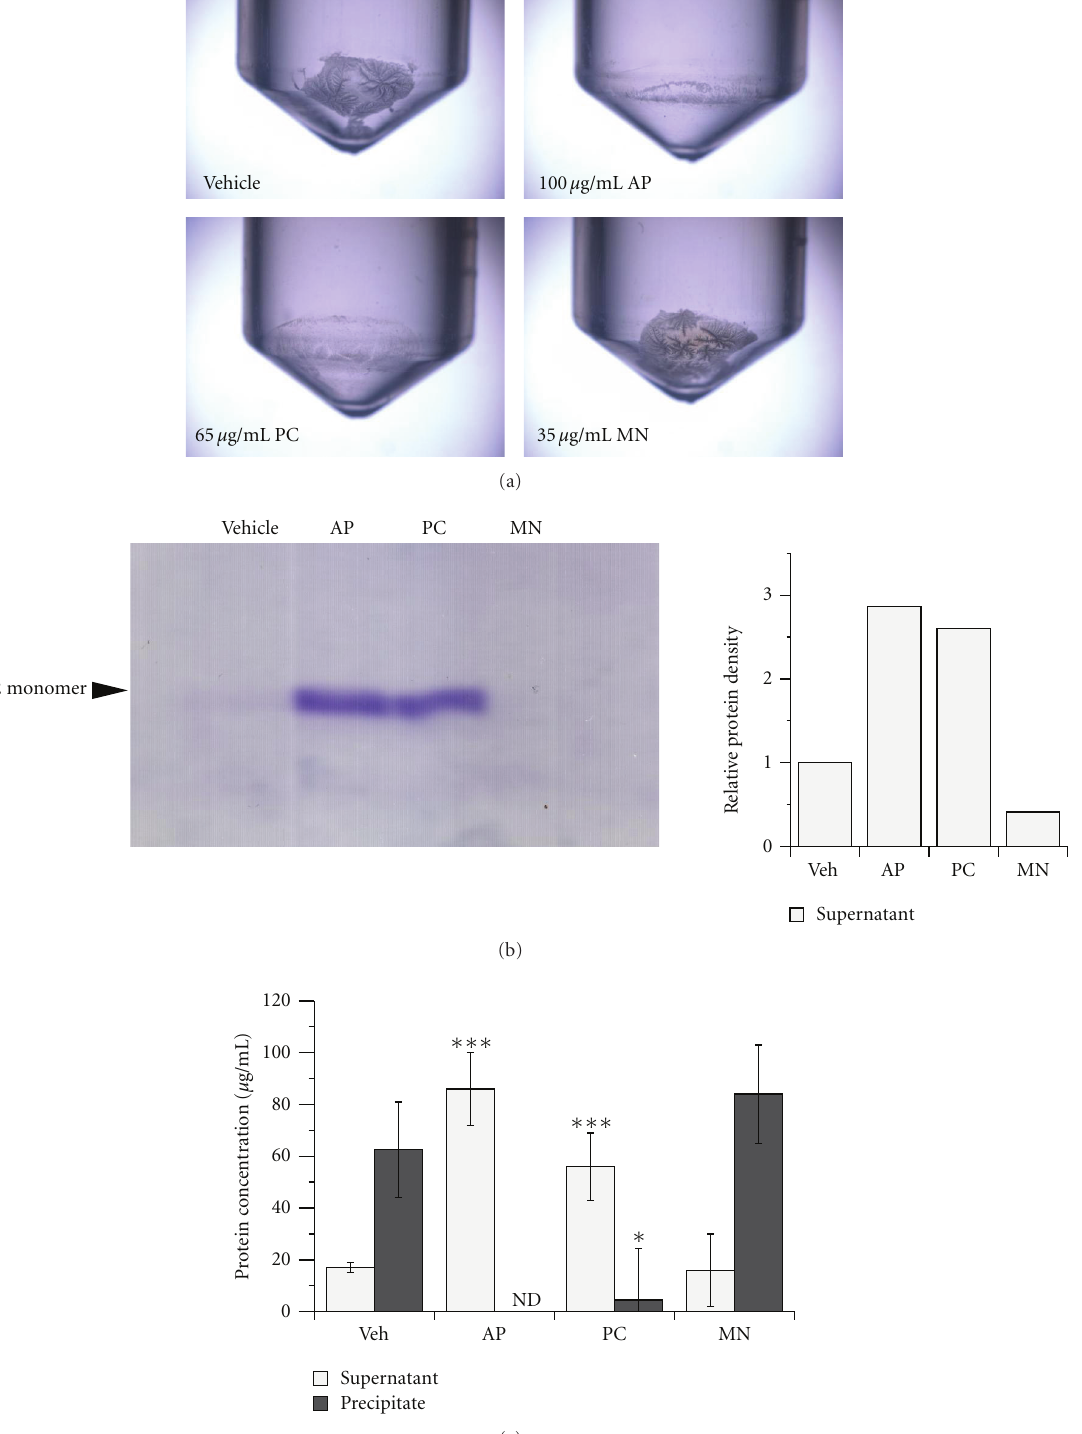
Figure 2: Procyanidins extinguish A β precipitation. (a) Microscopic observation of A β 42 precipitates by centrifugation in the presence of polyphenols. The aggregates were observed by 12.5-fold magnification. (b) SDS-PAGE analysis of soluble A β 42 peptide of supernatants in reaction mixtures. Arbitrary density of monomeric A β 42 bands was calculated in the right column, 5 μ L/lane. (c) A β concentrations of supernatant and precipitate in the reaction mixtures. AP (100 μ g/mL), PC (65 μ g/mL), and MN (35 μ g/mL) were incubated with A β 42 (20 μ M) for 24 hours and centrifuged to fractionate supernatants and pellets as described in Section 2 (ND: not detected; di ff erences compared to vehicle groups, ∗∗∗ P < 0 . 001 and ∗ P < 0 . 05 (Student’s t -test)). Values are the means ± s.e.m., n =